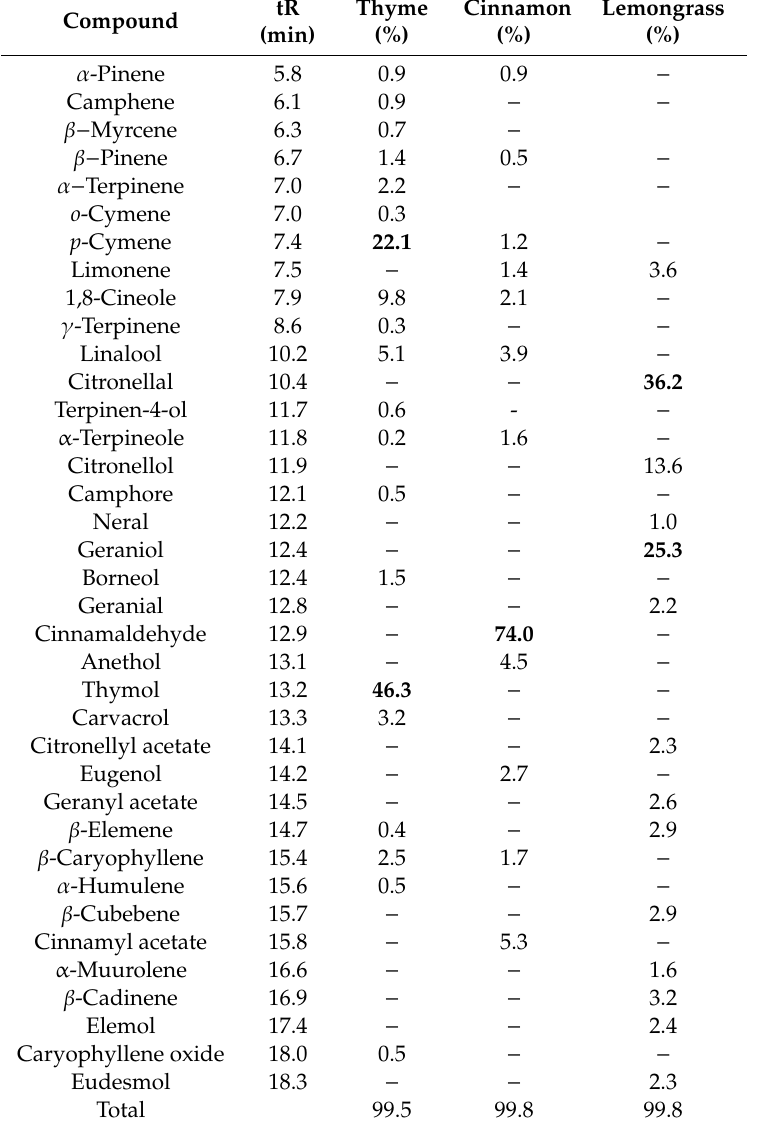
Table 1. The chemical composition of the investigated essential oils in percentage from 3 parallel measurements (main components in